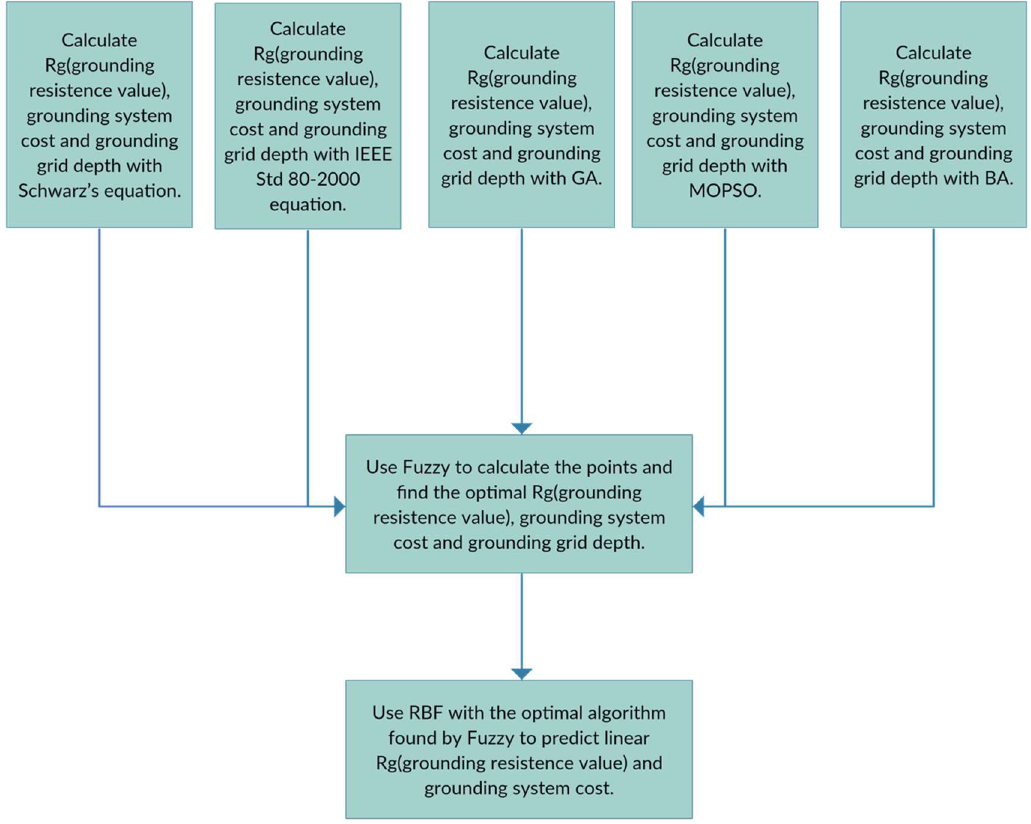
Figure 1. Grounding prediction system.